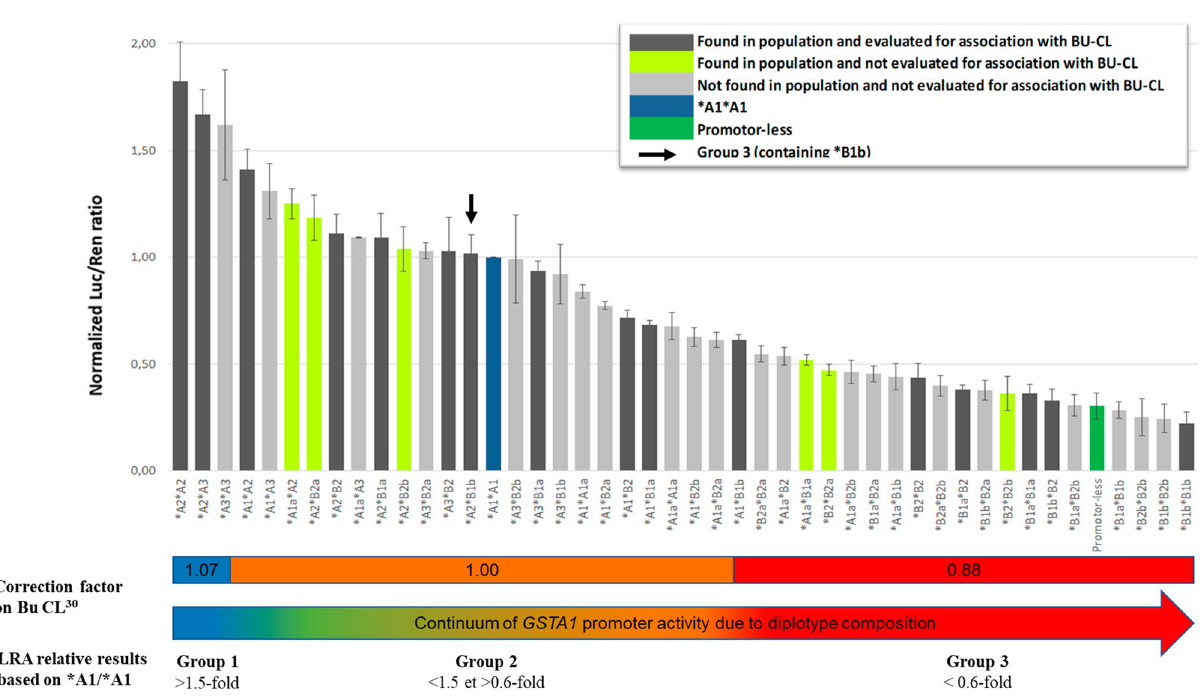
Figure 4. Predicted GSTA1 diplotype expression